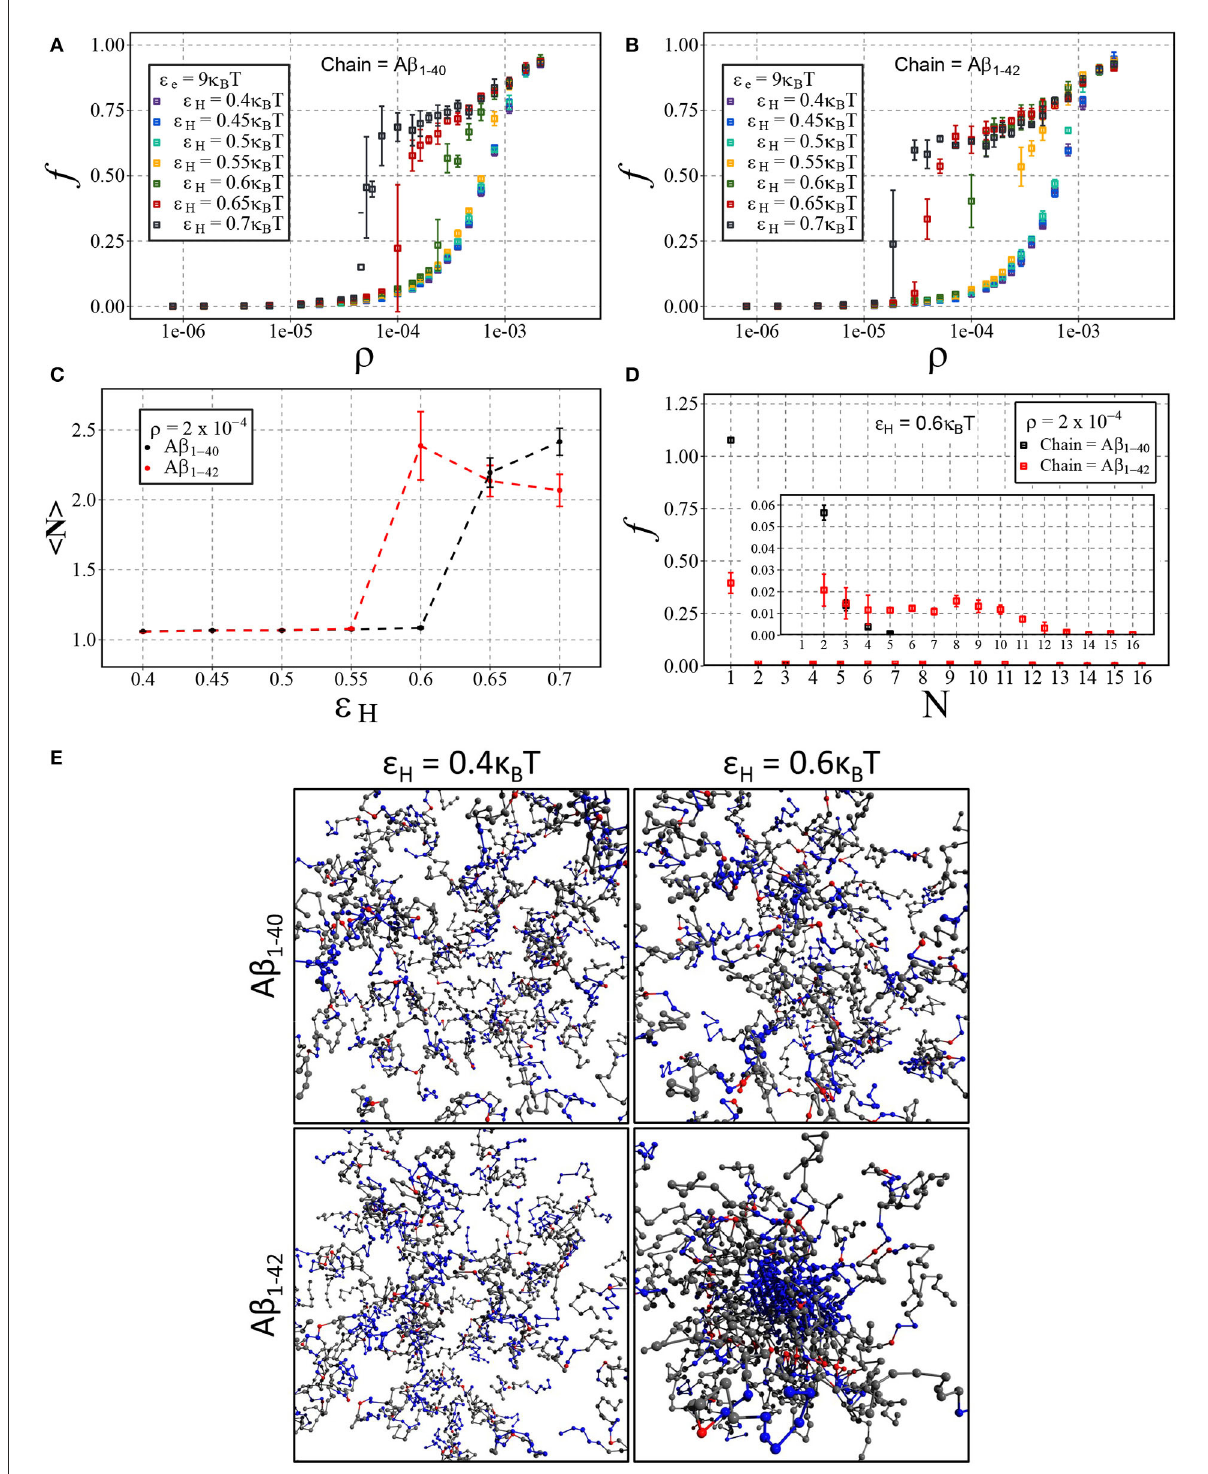
FIGURE7 A β aggregation with dimerisation (nucleation) energy ε n 3 k B T and elongation energy ε e 9 k B T . Each point represents the mean and standard = = deviation of 3 simulations. The fraction of aggregated material, f , is plotted against the number density, ρ (in units of the lattice spacing), for N varying values of ε H using either (A) A β 1 and (B) A β 1 . (C) Displays the change in mean cluster size, , against varying hydrophobic h i − 40 − 42 interaction energy, ε H , at a concentration of ρ 2 10 − 4 . (D) A size distribution plot with the fraction of material, f , plotted against the cluster = · size, N , with a fixed hydrophobicity of ε H 0.6 k B T at a concentration of ρ 2 10 − 4 . (E) Shown are snapshots taken from the end point of the = = · simulation for A β 1 and A β 1 at low ( ε H 0.4 k B T ) and high ( ε H 0.6 k B T ) = = − 40 − 42